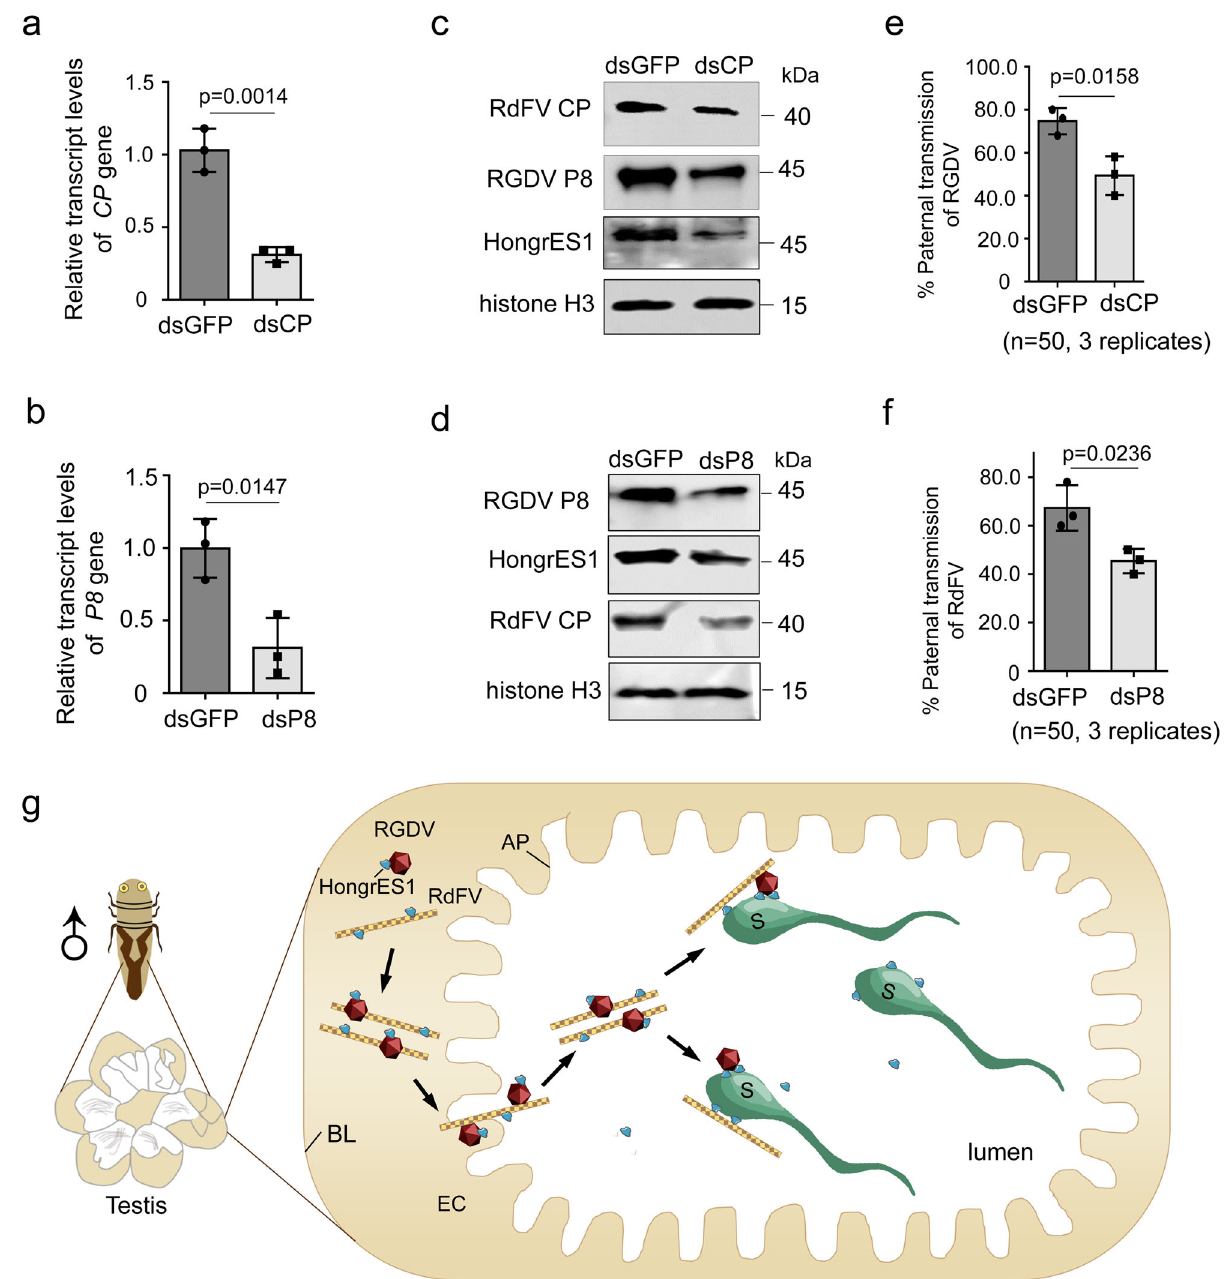
Fig. 6 | Direct interaction between RdFV CP and RGDV P8 mediates their co-parental transmission by male R. dorsalis . a , b RT-qPCR assays showing the transcript levels of RdFV CP ( a ) or RGDV P8 ( b ) in 30 male reproductive organs of dsGFP-, dsCP- or dsP8-treated RdFV and RGDV co-positive male adults. Means (±SD) from three biological replicates (two-tailed t-test) are shown. c , d Western blot assays showing the protein accumulation levels of RdFV CP, RGDV P8 and HongrES1 in 30 male reproductive organs of dsGFP-, dsCP or dsP8-treated RdFV andRGDVco-positivemaleadults.TheproteinsweretestedbyusingHongrES1,CP, P8 or histone H3 antibody. Bands for histone H3 demonstrate loading of protein. Data represent three biologicalreplicates. e , f Paternal transmission rates of RGDV orRdFV,asdeterminedbymatingofdsCP-,dsP8-ordsGFP-treatedRdFVandRGDV co-positive males with virus-free females. Ten pairs of mating combination were